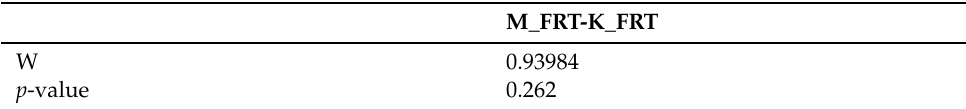
Table 1. Shapiro–Wilk normality test applied to data of Experiment 1.